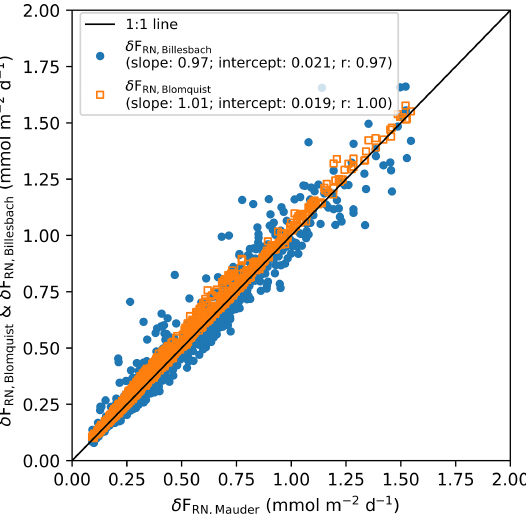
Figure C2. Comparison of random error in hourly flux due to instrument white noise, estimated by three different methods for the Arctic cruises. The three uncertainty estimations agree well. The correlation coefficient ( r ) between δF RN,Mauder and δF RN,Blomquist is 1 if the √ constant in Eq. (7) ( a ) is set to